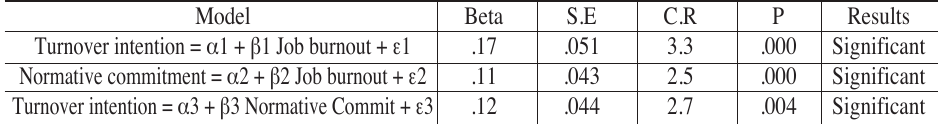
Normative Commitment Mediates b/w Job Burnout and Turnover Intention